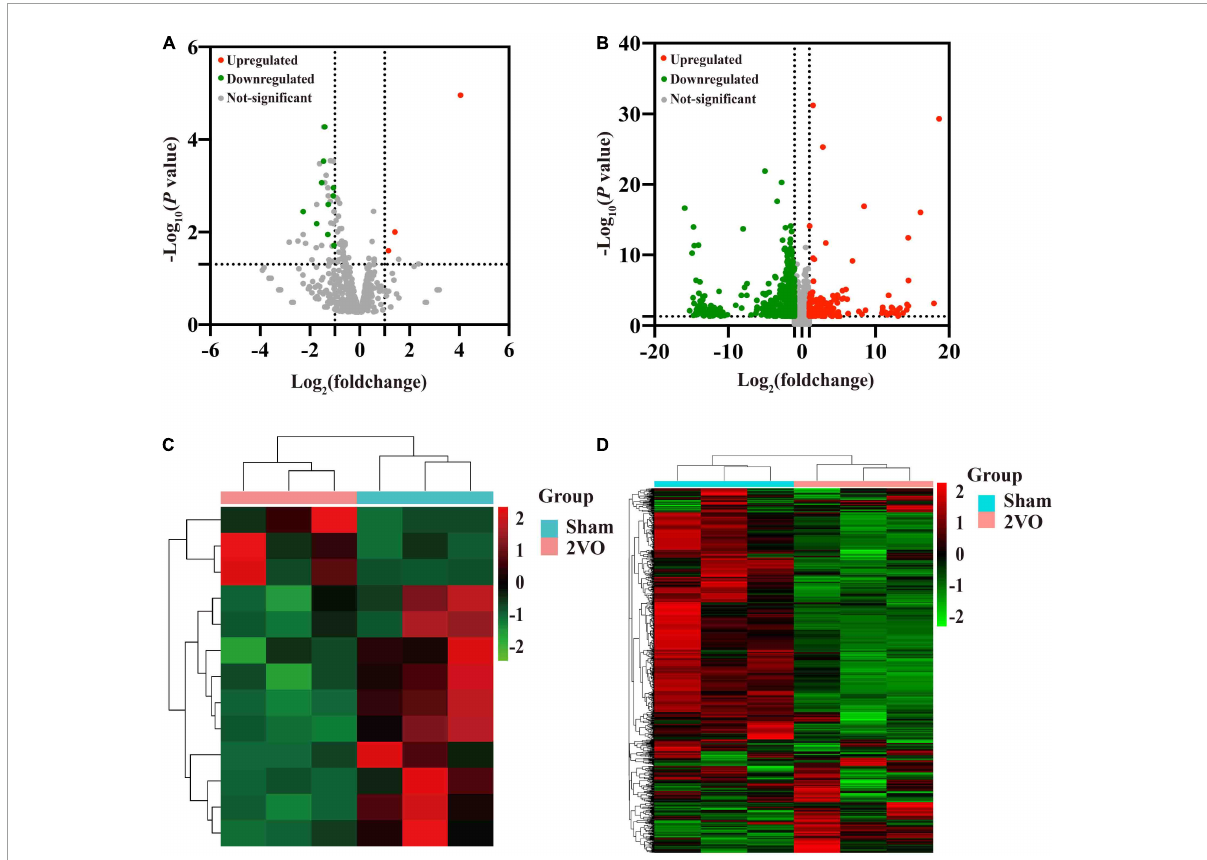
FIGURE3 Volcano plots of the transcriptome and hierarchical cluster analysis of the DEMs and DEGs in the cortex of 2VO and sham rats. (A) Volcano plots of the differentially expressed miRNAs (DEMs) in the cortex of rats with 2VO compared with sham rats. (B) Differentially expressed mRNAs (DEGs) in the cortex of rats with 2VO compared with sham rats. Red dots indicate the upregulated DEMs and DEGs in the brains of rats with 2VO, while green dots indicate downregulated DEMs and DEGs. The molecules with no statistically different changes in rats with 2VO are shown as gray dots. (C) Hierarchical clustering analysis of DEMs. (D) Hierarchical clustering analysis of DEGs. The X -axis shows the cluster analysis of samples, the top blue bar indicates the sham group, and the top red bar indicates the group of rats with 2VO. The Y -axis shows the cluster analysis of miRNAs or mRNAs. Upregulated DEMs and DEGs are shown in red, and downregulated DEMs and DEGs are shown in